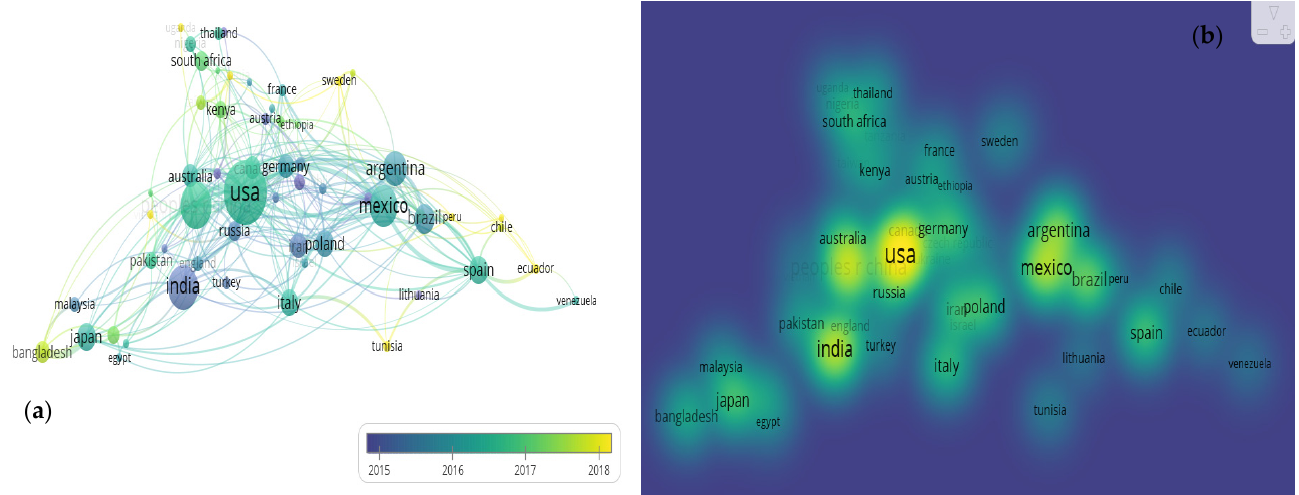
Figure 6. Co-authorship countries on Amaranthus research. Overlay visualization ( a ), density visualization ( b ).